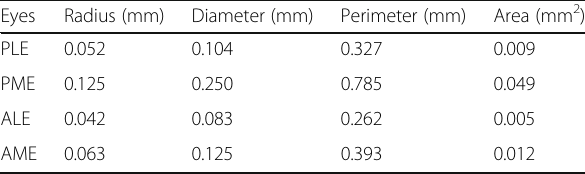
Table 2 Measurements of eyes of Pardosa brevivulva